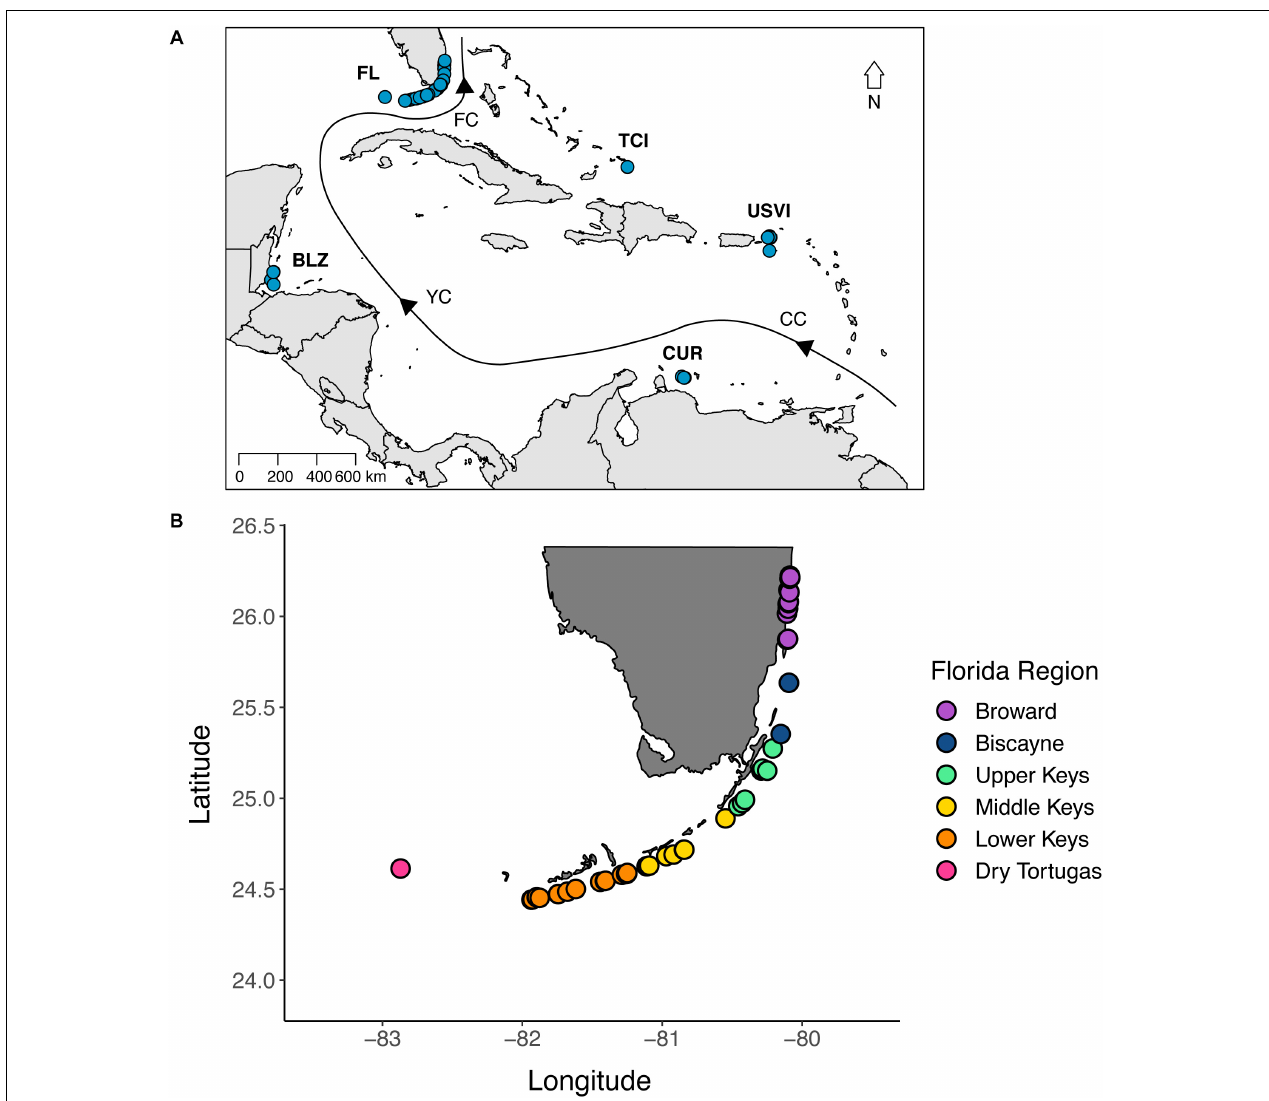
FIGURE 1 | (A) A map of the sites where tissue samples of Dendrogyra cylindrus were collected. Samples were collected from 51 sites along the Florida Reef Tract (FL), three sites in Curaçao (CUR), six sites in the U.S. Virgin Islands (USVI), three sites in Belize (BLZ), and four sites in the Turks and Caicos Islands (TCI). The black line with arrows indicates the direction of ocean currents. CC, Caribbean Current; YC, Yucatan Current; FC, Florida Current. See text for sample sizes. (B) A map of the Florida collection sites, colored by region. More samples were collected from Florida to enable the description of clonal structure and to delineate the relationship between genetic and geographic